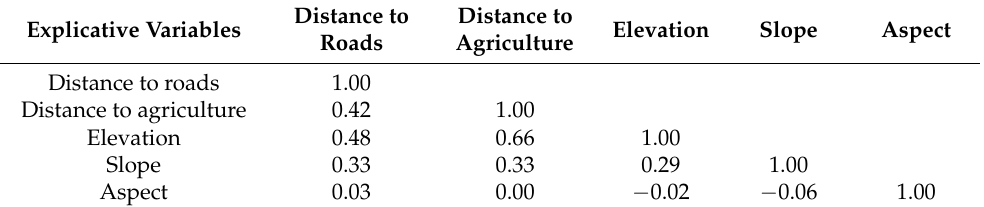
Table A6. Pearson correlation between (numeric) explicative variables for TDF gain.